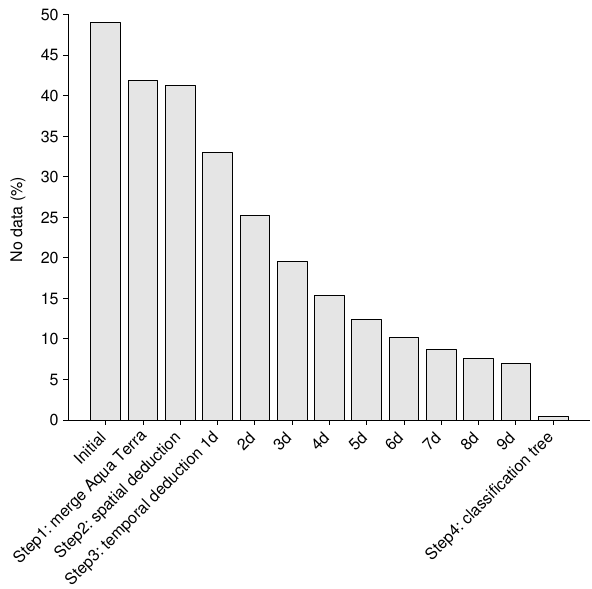
Figure 7. Evolution of the number of pixels classified as no-data (e.g., clouds) during the gap-filling procedure.